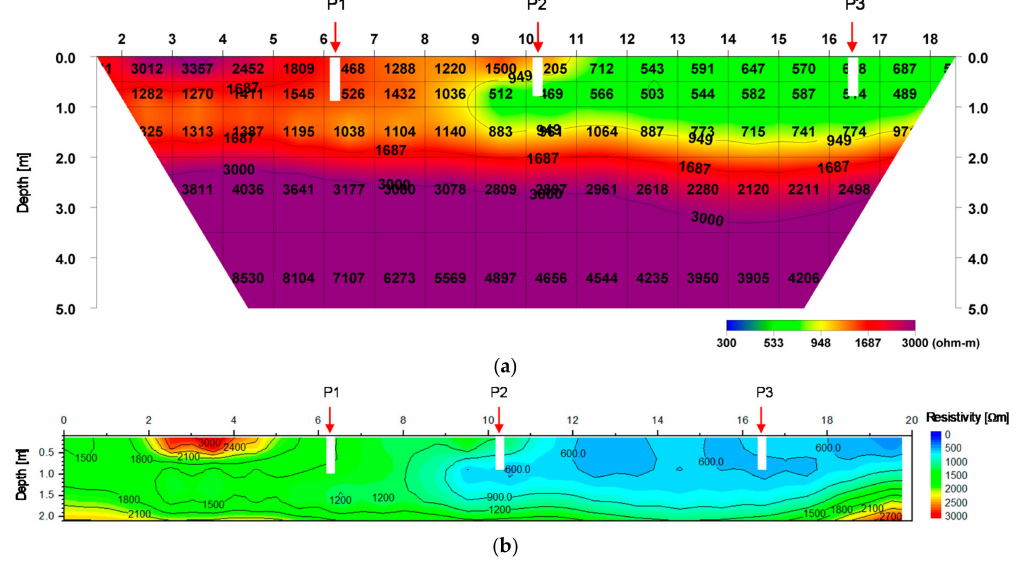
Figure 10. Resistivity tomograms of a selected line up to: ( a ) 5 m depth; ( b ) 2 m